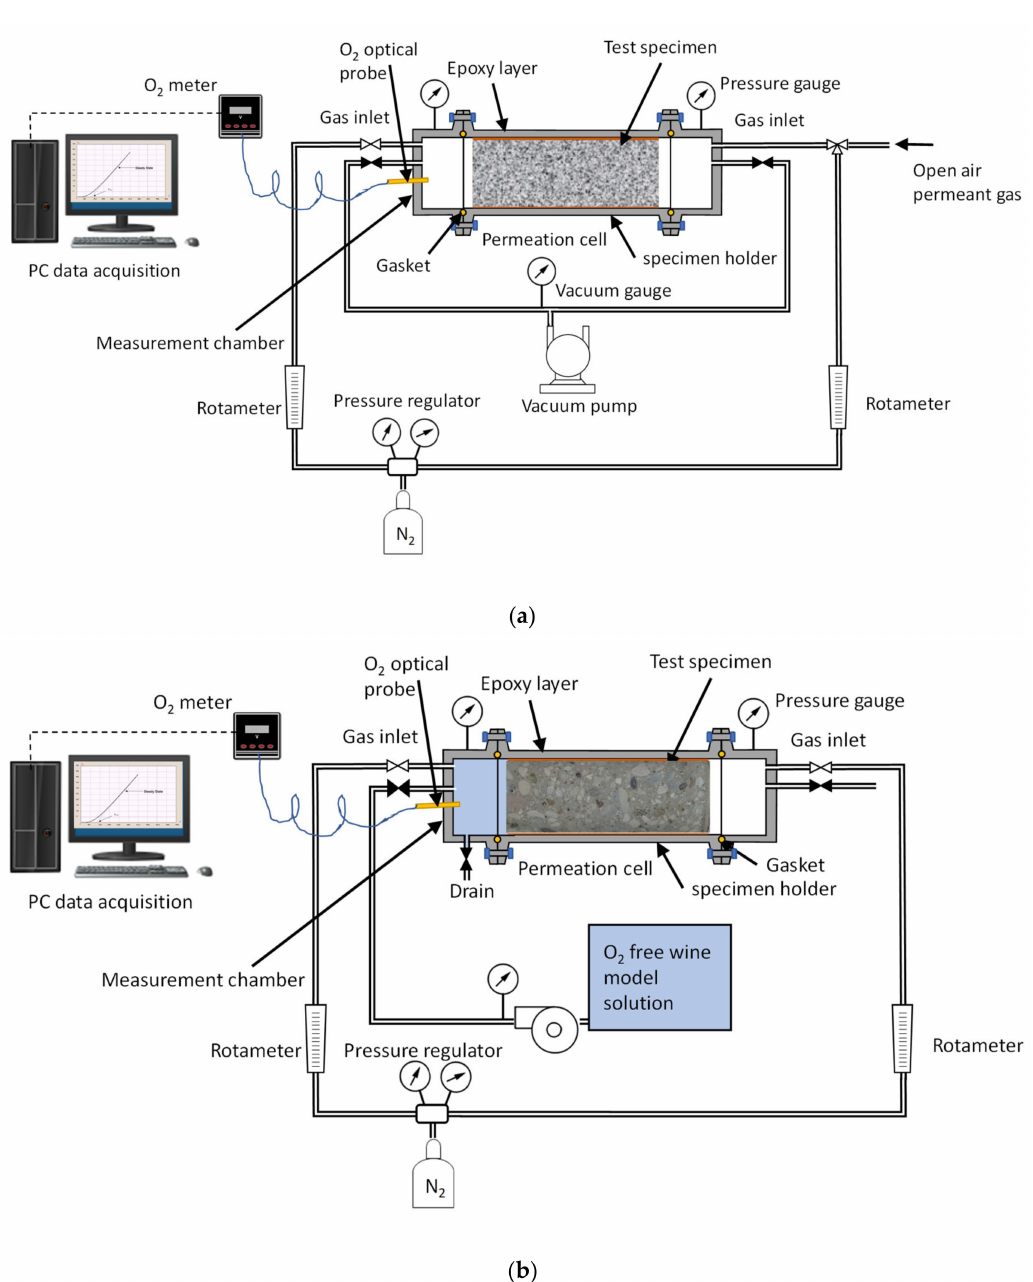
Figure 9. Setup for the specimen tests, ( a ) time lag mode and ( b ) fluid contact mode with gas (dry mode), with the wet material (wet mode) or measuring in model wine instead of in gas (liquid contact